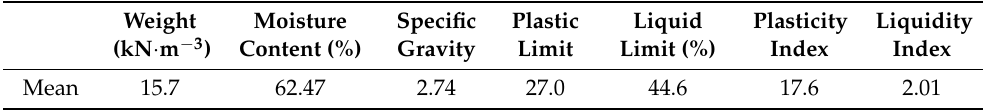
Figure 1. Test soil sample. Table 1. Basic physical parameters of the soil